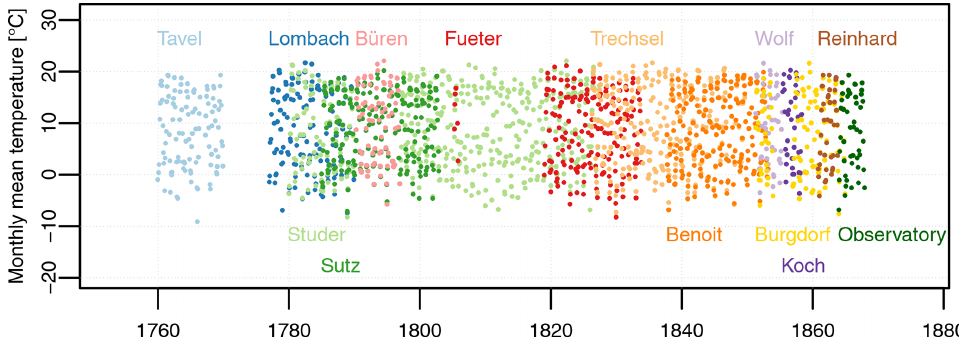
Figure 3. Monthly means of the raw data used to build the Bern series with observers’ names or locations. Table 1. Records contributing to the daily temperature series of Bern (elevations are estimated). The employed temperature scales are Micheli du Crest (MdC), Réaumur (R), and Celsius